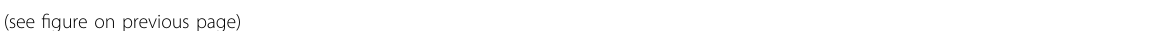
Fig. 6 Integration of functional association and co-expression networks. a Intersection of the two different networks leads to the identi fi cation of two small modules (CCCh1 and CCCh2) connected in the context of general aging and brain aging. CCCh means “ Components Connected and Co- expressed in the aging hippocampus ” . b Networks starting from each gene or whole genes of CCCh were grown through the iterative addition of the most signi fi cant interaction partner until the expanded modules reach100 nodes. The expanded modules starting from individual genes were compared to the expanded module starting from whole genes of CCCh. X axis points to the gene number of expanded modules and Y axis to proportion of overlap between the two expanded modules. Legends in the upper left of the plots correspond to the seed genes (starting individual genes). c Excess retention analysis showed that CCCh1 tends to be located at the periphery of aging module1 (association network or part of interactome) and at the hub of yellow co-expression module. An m -core of x axis means a network consisting of genes with a degree of at least m and is generated by removing the genes with a degree less than m . Y -axis indicates the enrichment of genes with certain properties (in this case, CCCh1 and CCCh2) in each m -core. For example, a set of genes close to or at the hub tend to show an increasing pattern in the analysis but a decrease in genes at the periphery with increasing m